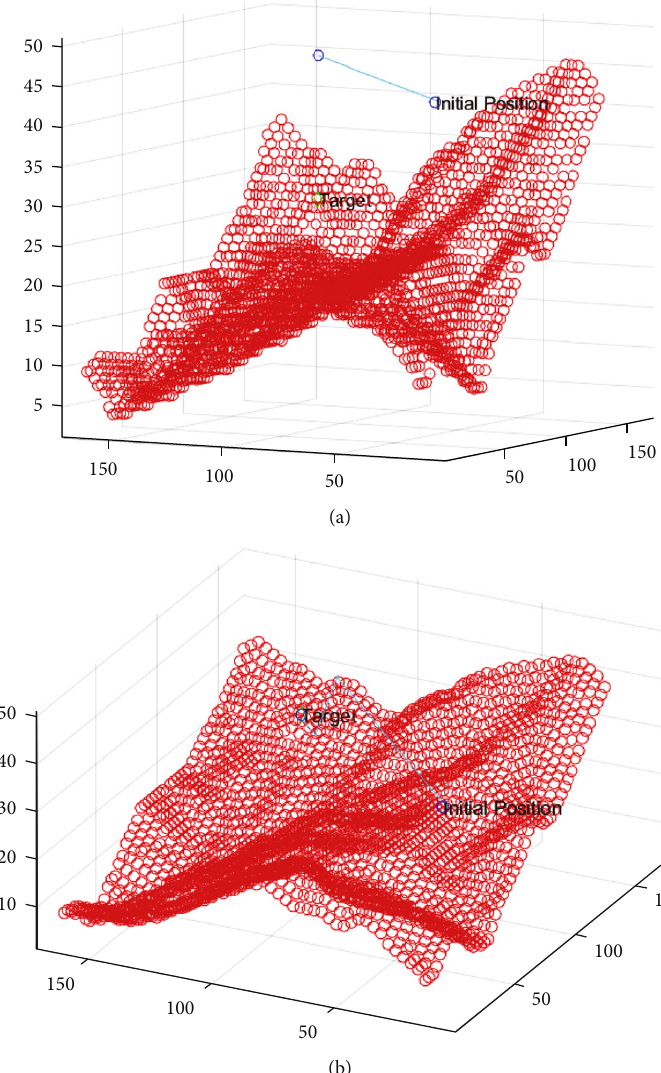
Figure 8: Path planning for simulating group 1 with the optimal A ∗ algorithm (a) and traditional A ∗ algorithm